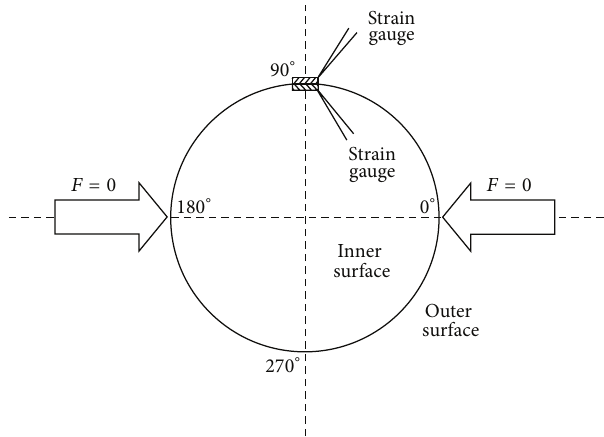
Figure1:Positionofthestraingauges on theinnersurfaceand outer surface of the toroid and direction of the applied forces.